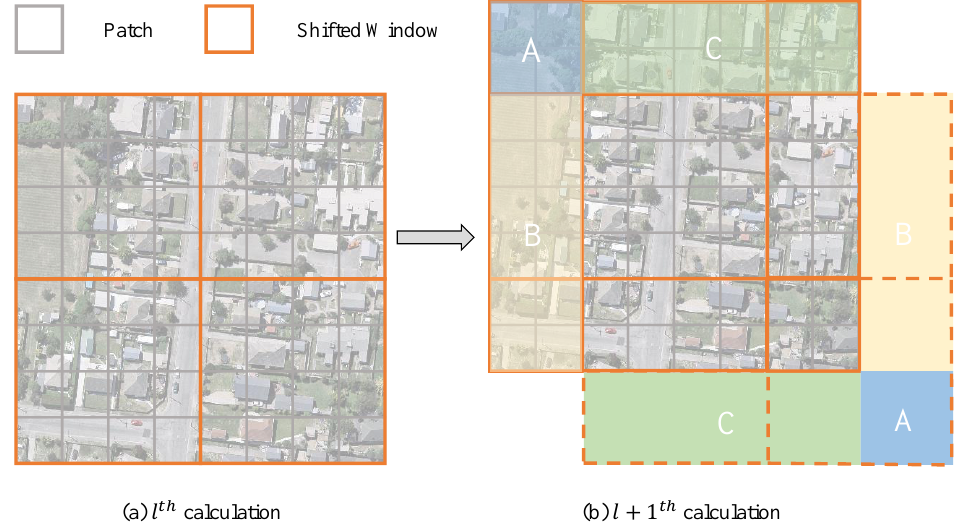
Figure 2. The global self-attention computation with the shifted-window (swin) design, comprising two continuous calculation steps ( a ) normal computation on each window area (within solid orange box) and ( b ) masked computation on each unmoved window area (within solid orange box) and each spliced window area (within dotted orange